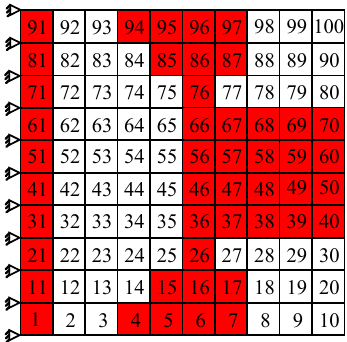
corresponding to the full coating structure are all listed in Table 7.